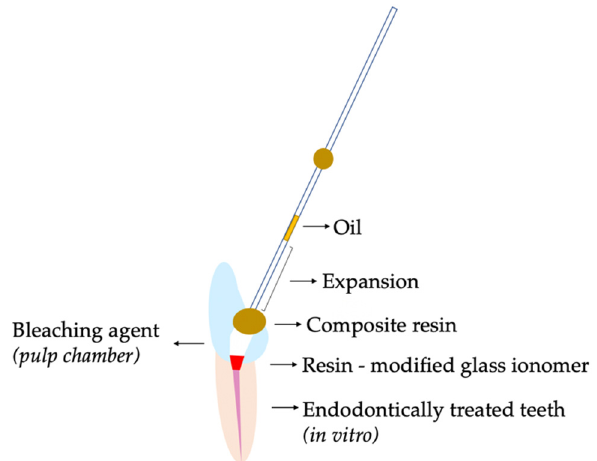
Figure 1. The experimental model, with the endodontic tooth and the assembled glass